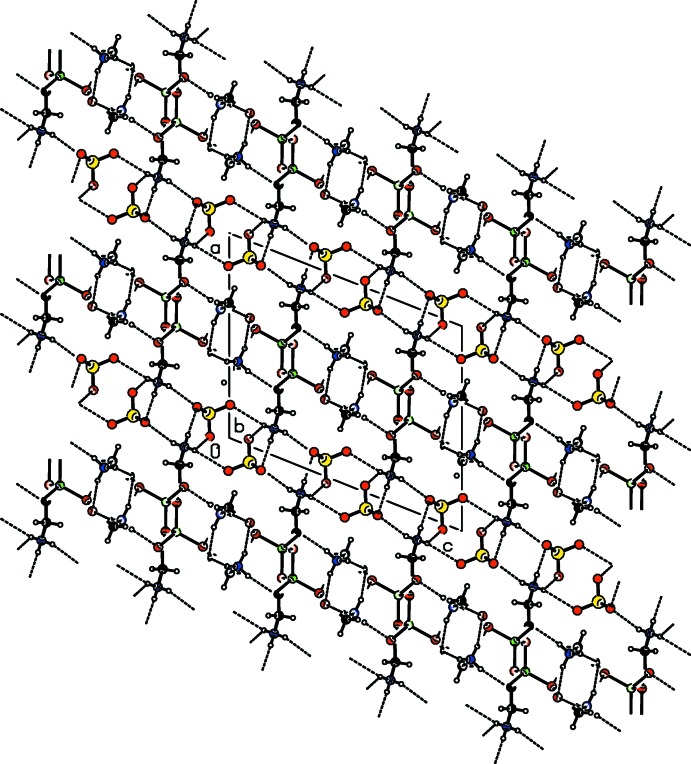
The crystal structure of (I), comprising alternate layers of Li–glycinium units and perchlorate anions, viewed down the b axis. Hydrogen bonds are indicated by dashed lines.